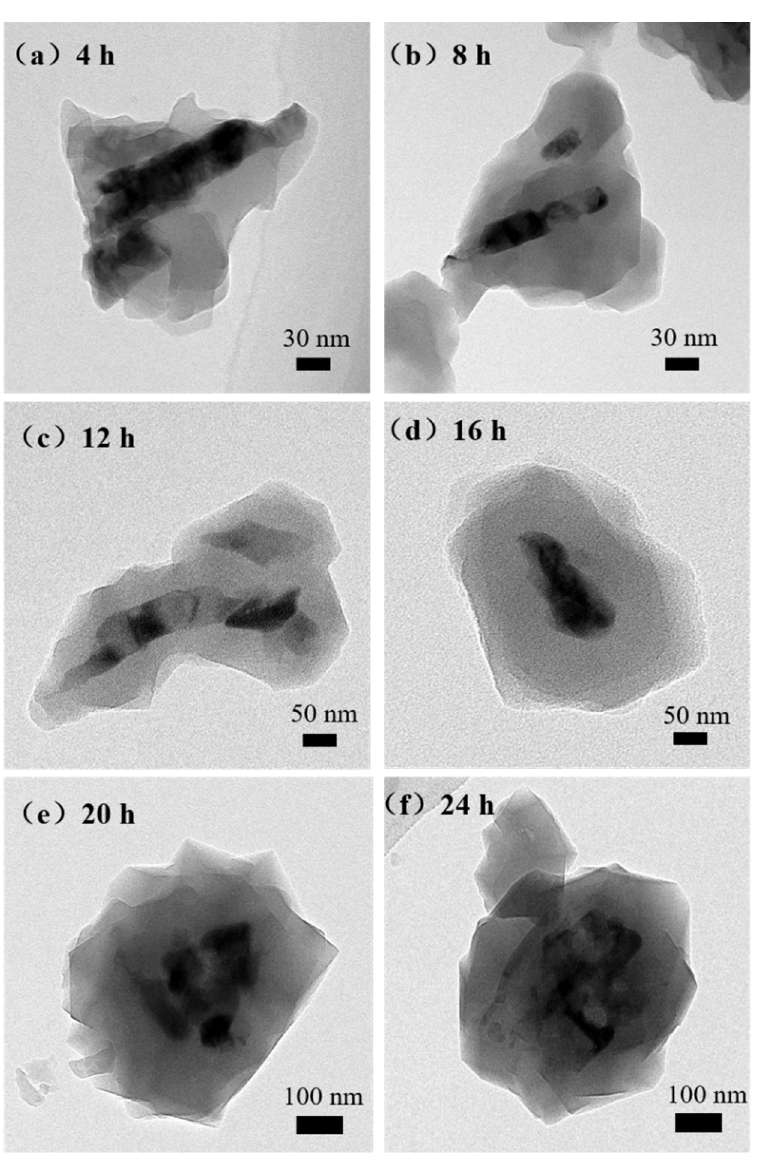
Figure 7. TEM images of the ZnO@ZIF-8 with different treating time: ( a ) 4 h; ( b ) 8 h; ( c ) 12 h; ( d ) 16 h; ( e ) 20 h; ( f ) 24 h. Figure 8a is a TEM dark field image of the 20-ZnO@ZIF-8 gas sensor. The bright area